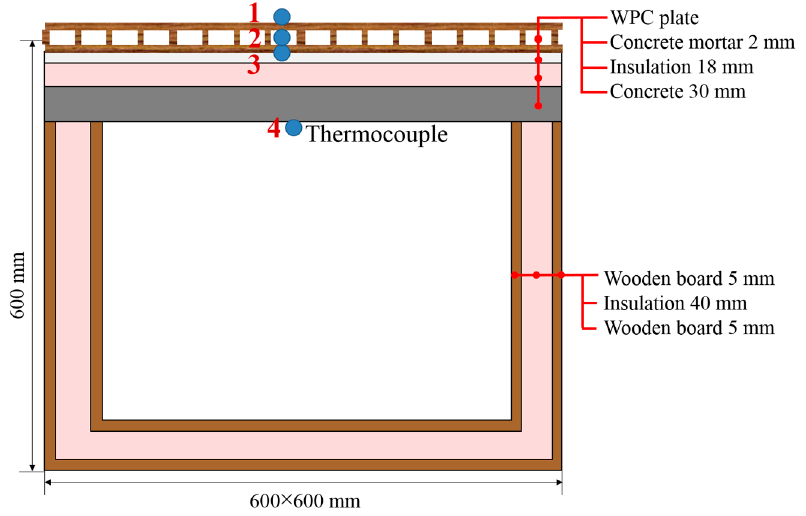
Figure 4. Dimensions of the scale model and the temperature measurement locations. Table 1. Thermal conductivity of a roof.